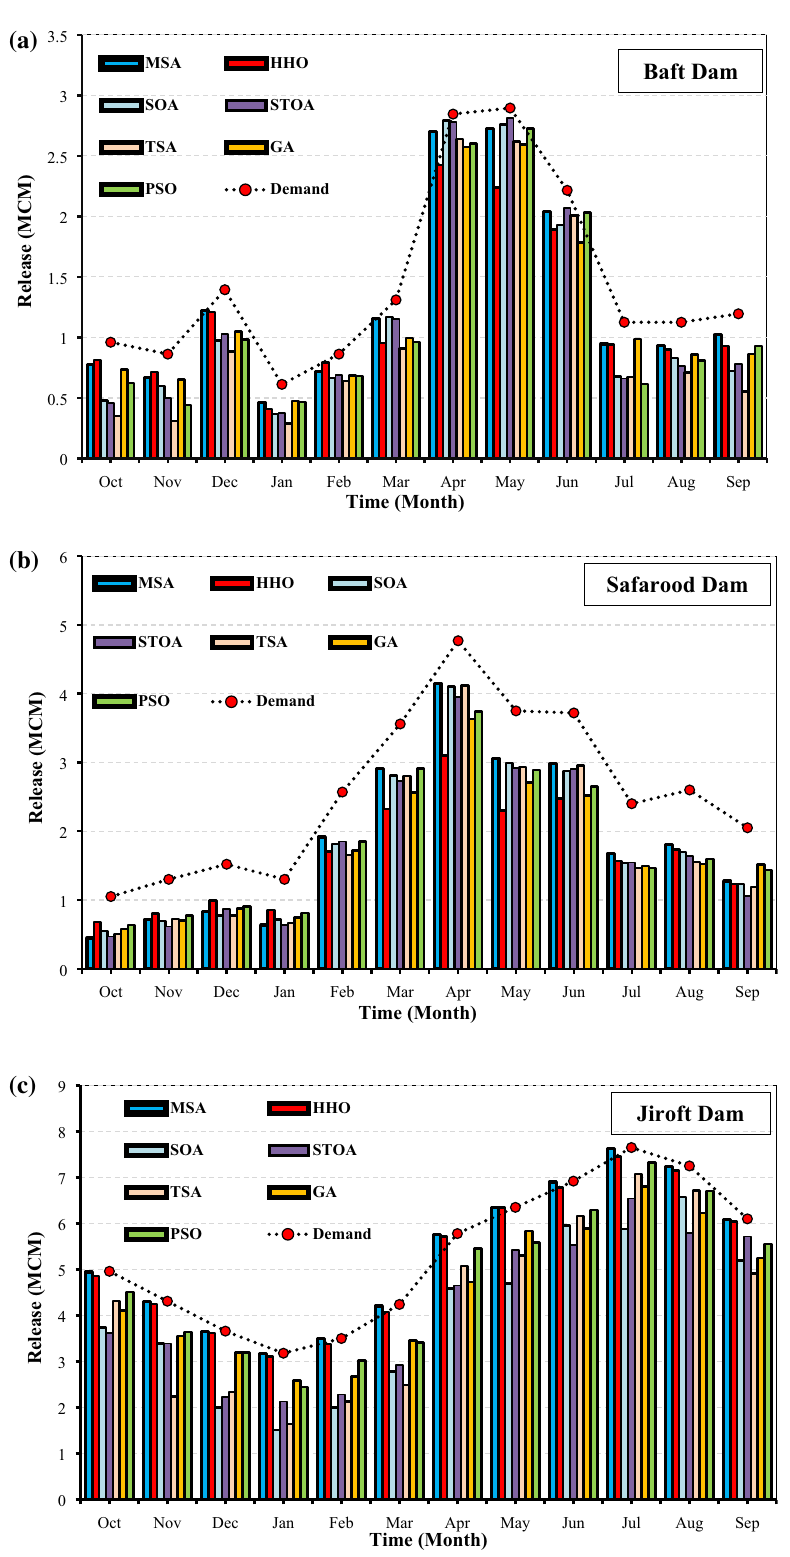
Figure 12. ( a ) Average monthly release and demand of Baft reservoir. ( b ) Average monthly release and demand of Safarood reservoir. ( c ) Average monthly release and demand of Jiroft